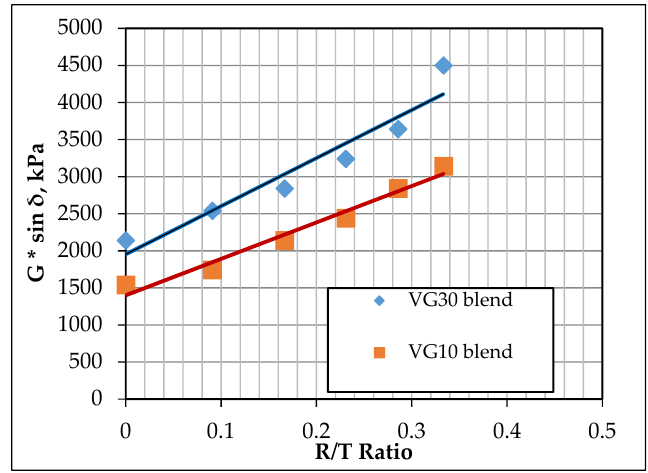
Figure 3. Variation of G * sin δ with R/T Ratio.